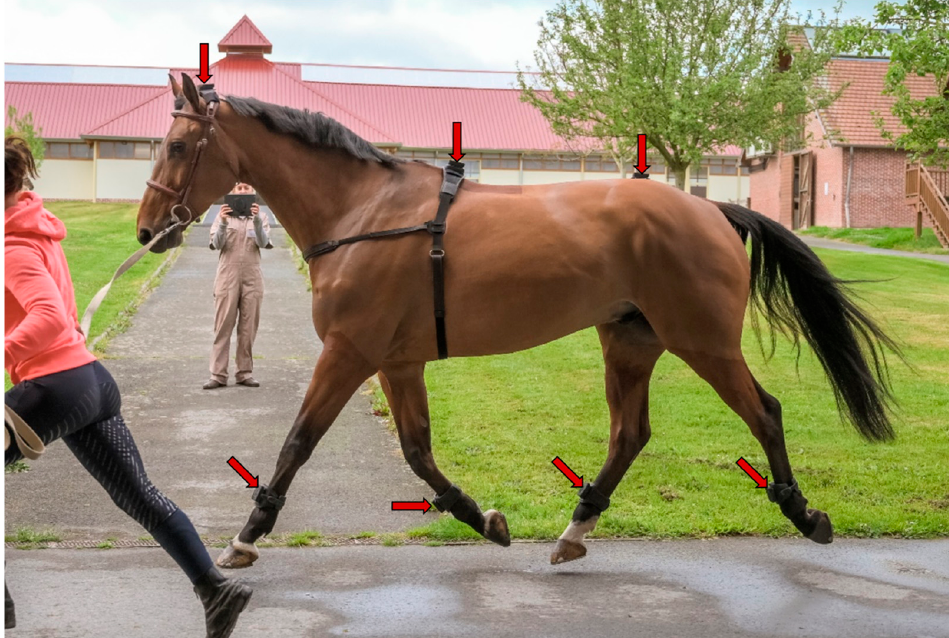
Figure 1. Horse equipped with EQUISYM ® system, composed by sensors placed on the head, the withers, the pelvis and the 4 cannon bones (indicated by red arrows).